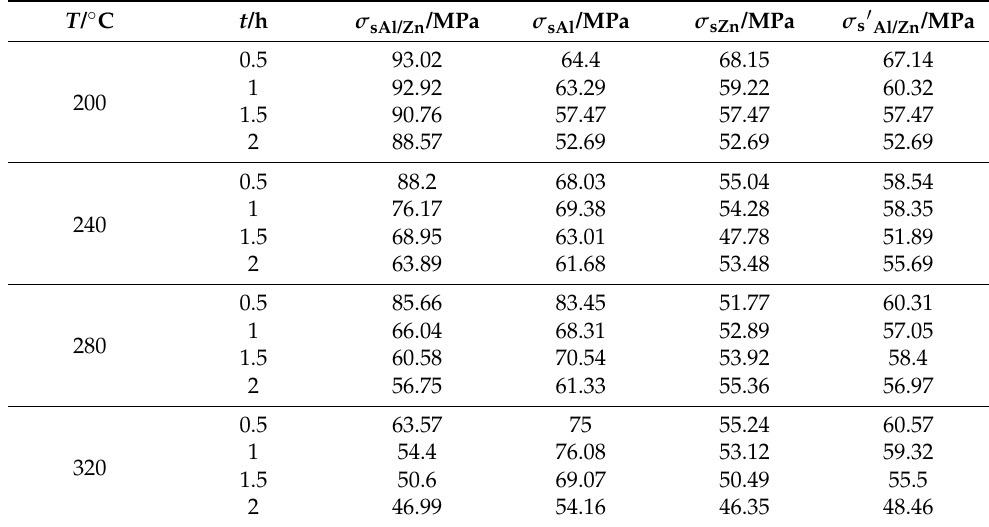
Table 5. Yield strengths of Al/Zn LMCs, pure Al and pure Zn and the calculated yield strengths of Al/Zn LMCs, σ sAl/Zn , σ sAl , σ sZn and σ s (cid:48) Al/Zn . T / ◦